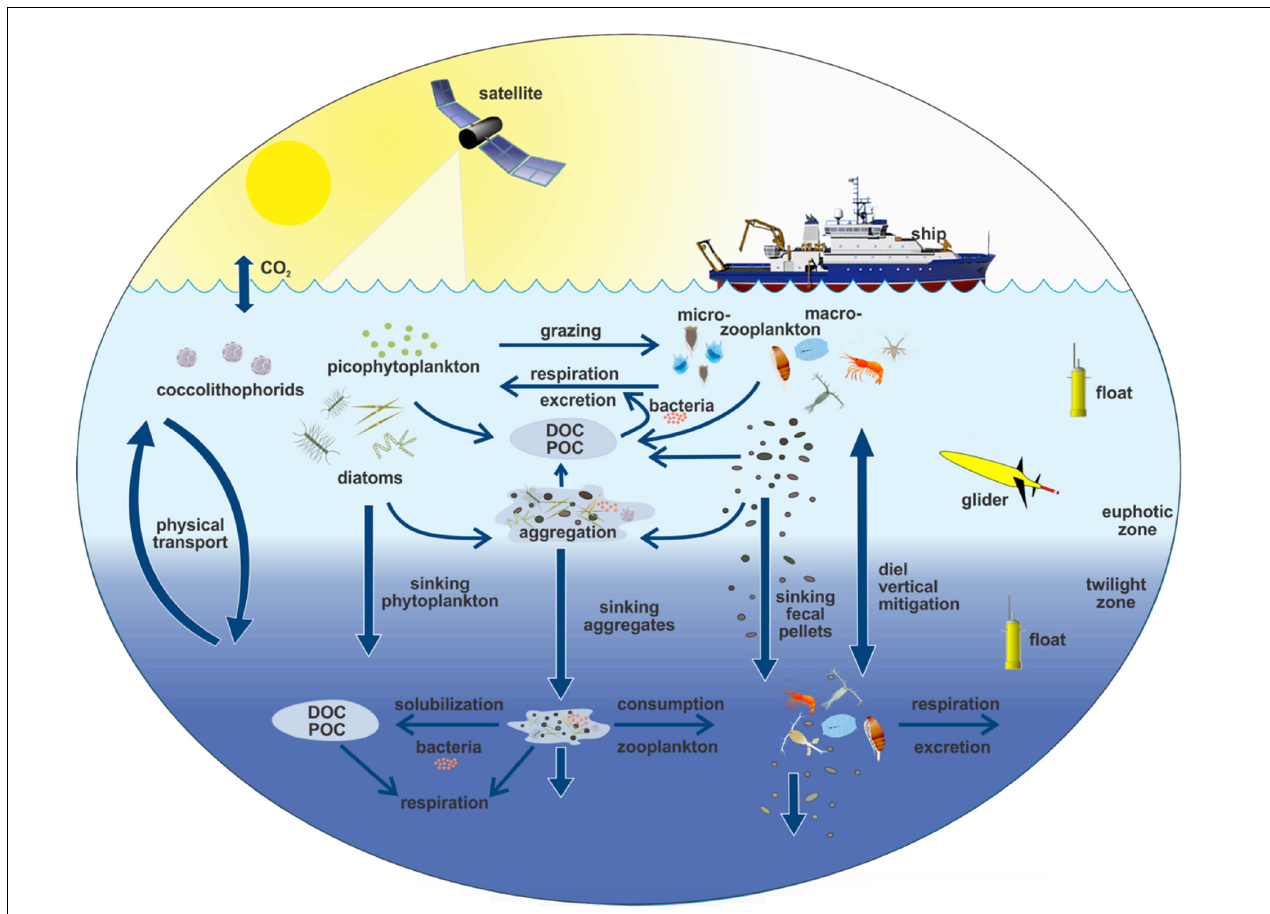
FIGURE 6 | Schematic of EXport Processes in the Ocean from Remote Sensing (EXPORTS) sampling campaign that includes ships, moorings, floats, gliders, sediment traps, and satellite observations. EXPORTS is a large-scale NASA-led field campaign that is leveraging existing ocean time series and other ocean observing assets to provide critical information for quantifying the export and fate of upper ocean net primary production (NPP) using satellite observations and state of the art ocean technologies. Figure from Siegel et al. (2016).